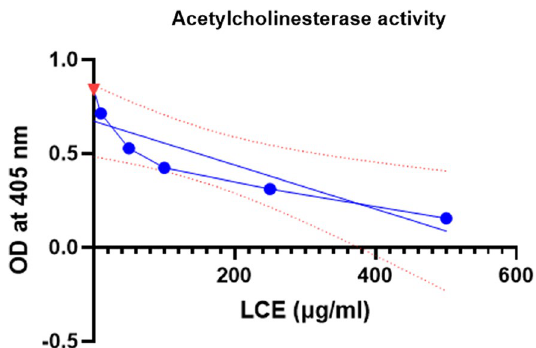
Fig. 6 Percentage Inhibition of Ache in Luffa cylindrica extract